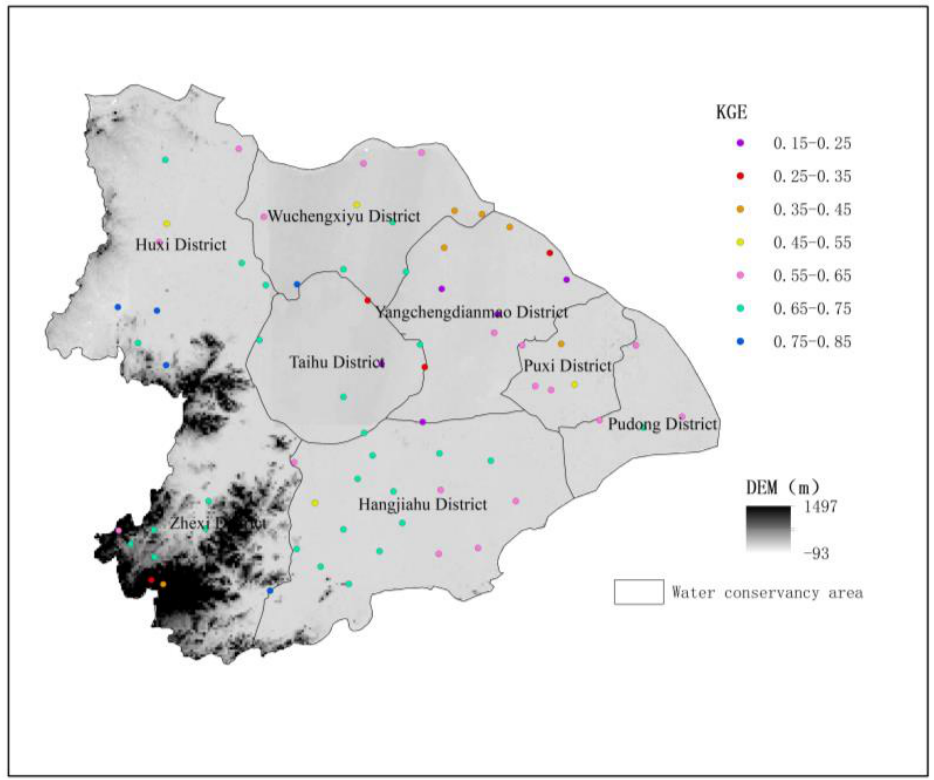
Figure 12. KGE values for the daily precipitation of the GWR model at 70 gauge sites in 2015.